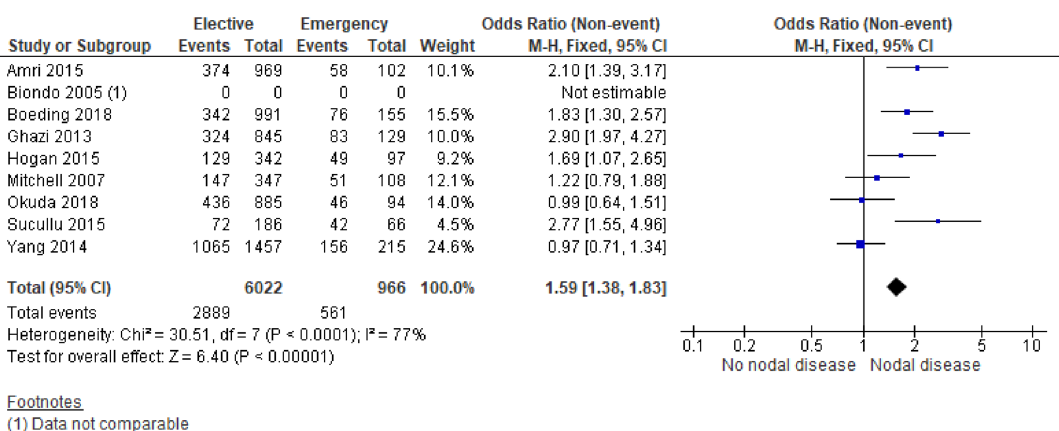
Figure 6. Association between N Stage and emergency presentation—Forest Plot.